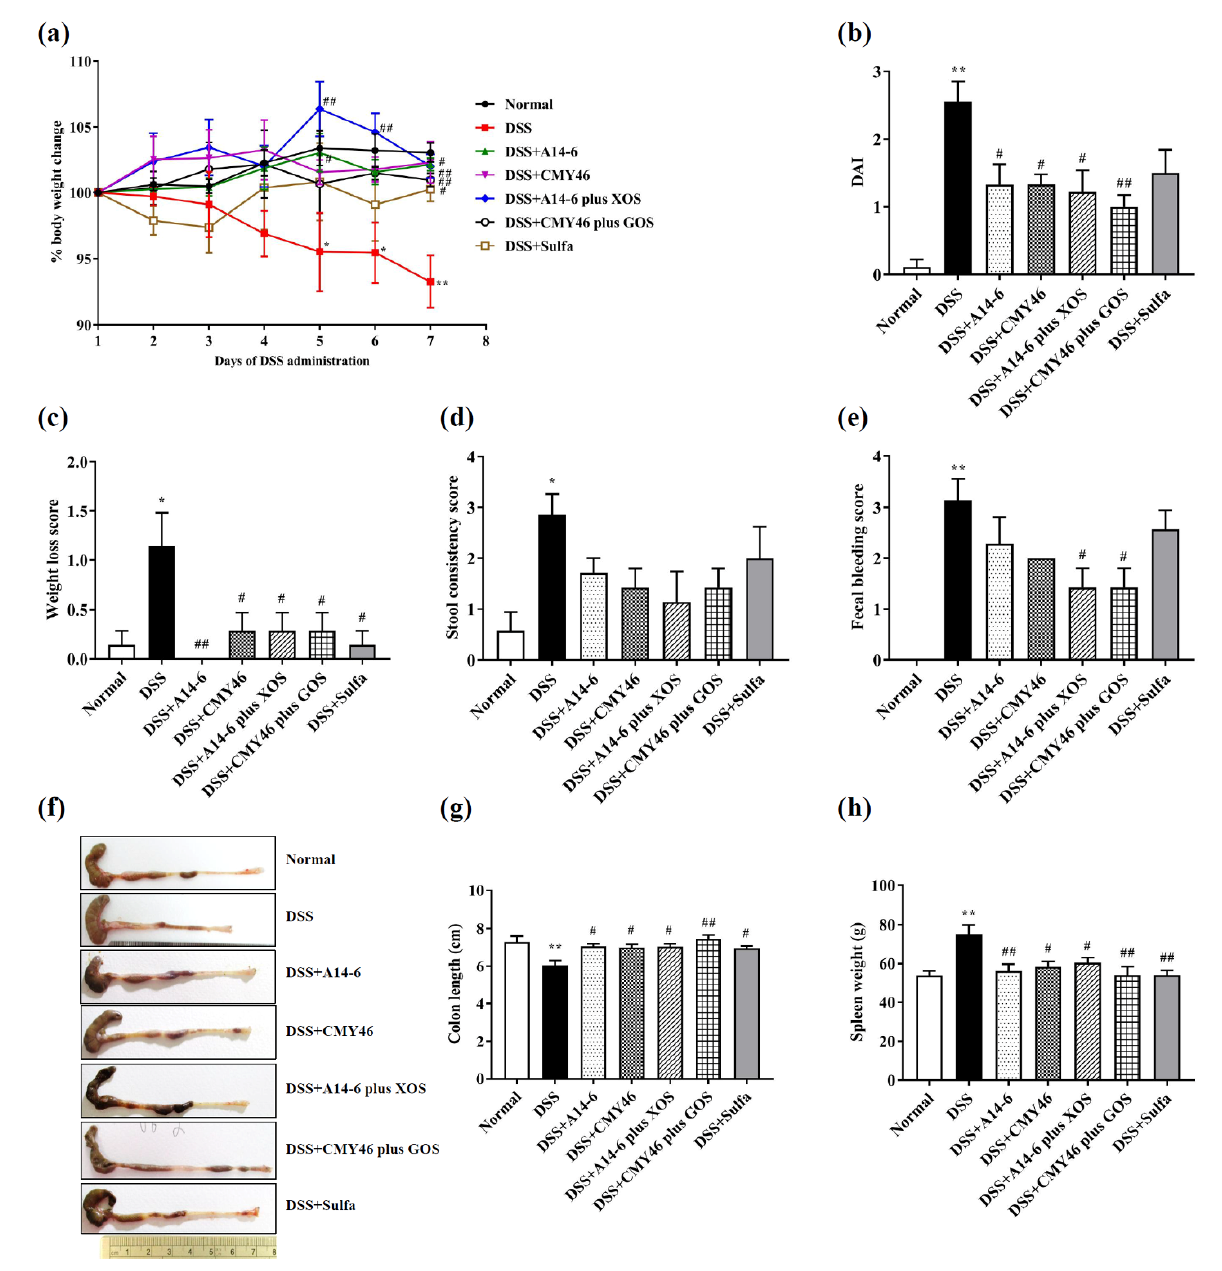
Figure 2. The effects of probiotics and synbiotics on clinical symptoms and severity of colitis induced by DSS. ( a ) The body weight; ( b ) DAI; ( c ) weight loss score; ( d ) stool consistency score; ( e ) fecal bleeding score; ( f ) representative macroscopic images of colons from each mice group; ( g ) colon length; ( h ) spleen weight. Data expressed as mean ± SEM ( n = 7). * p < 0.05; ** p < 0.01 vs. normal group. # p < 0.05; ## p < 0.01 vs. DSS group.